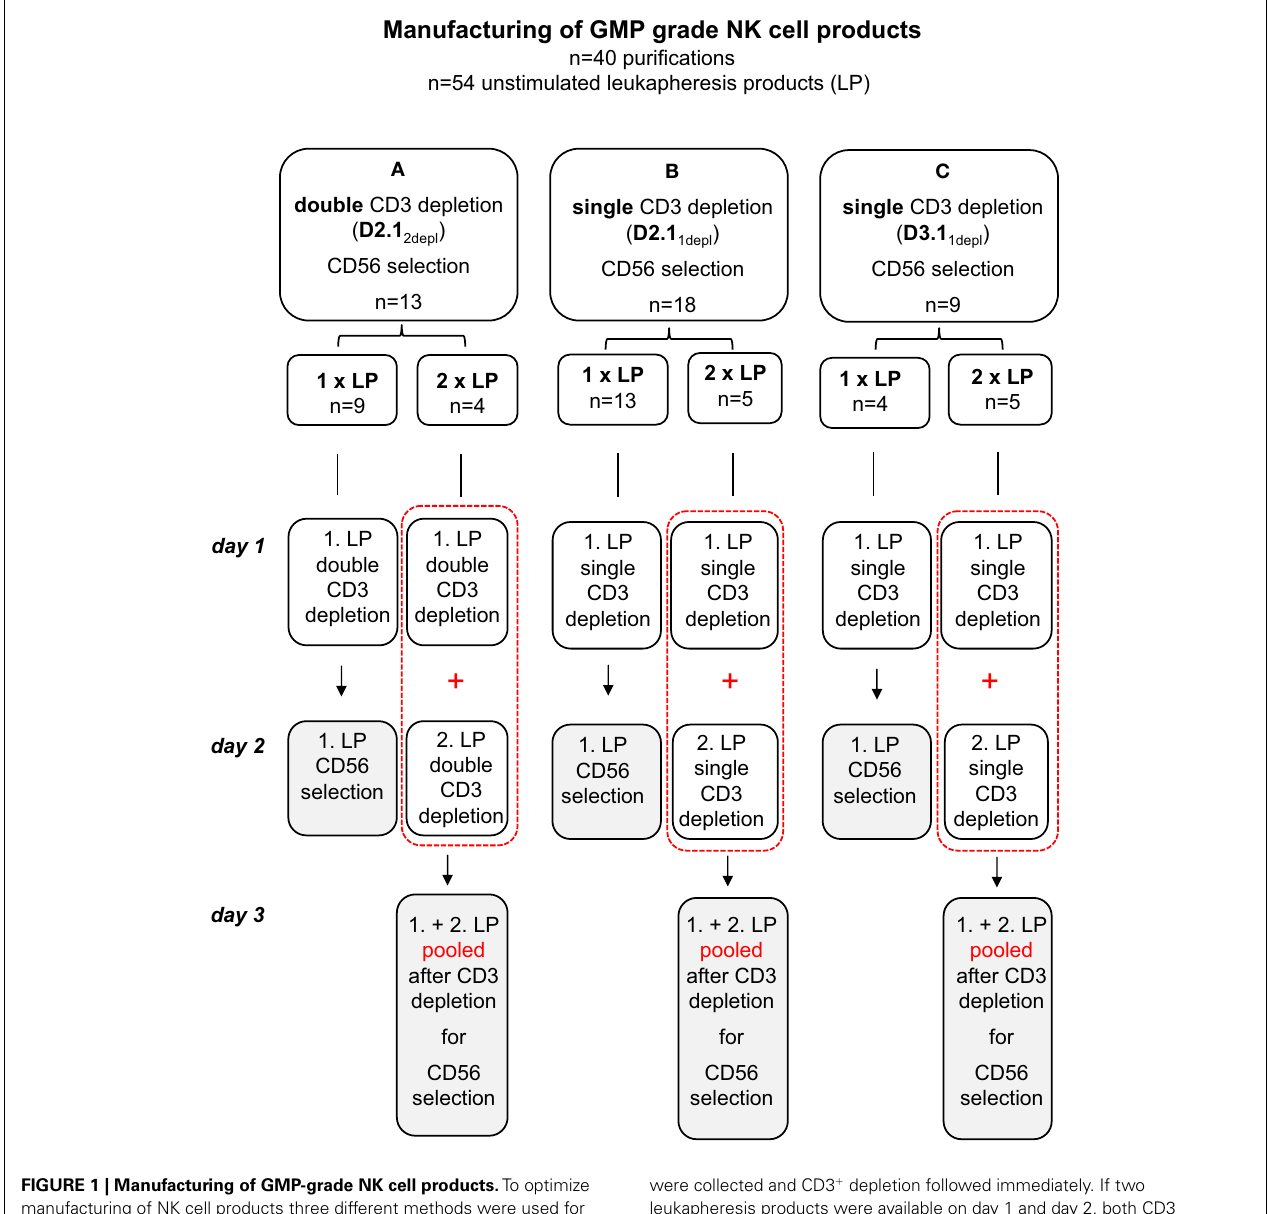
FIGURE 1 | Manufacturing of GMP-grade NK cell products. To optimize manufacturing of NK cell products three different methods were used